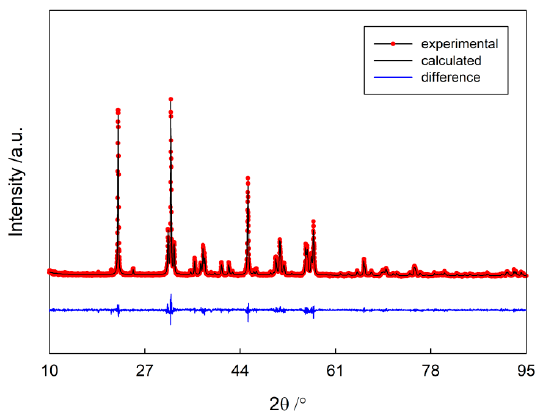
Figure 3. Rietveld refined XRPD pattern of the NaMnF 3 sample (ICSD: 98-006-7745) prepared without sodium citrate ( χ 2 = 1.37).